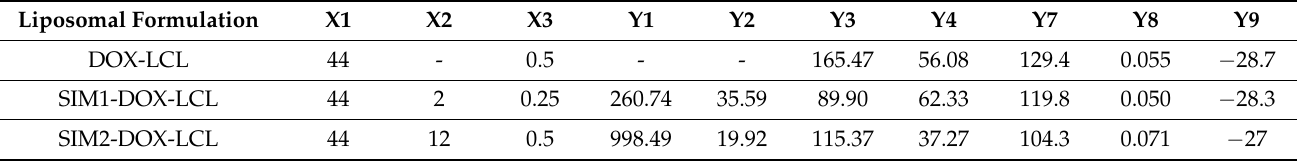
Table 5. The composition and the quality attributes of liposomes used in the proliferation assay.